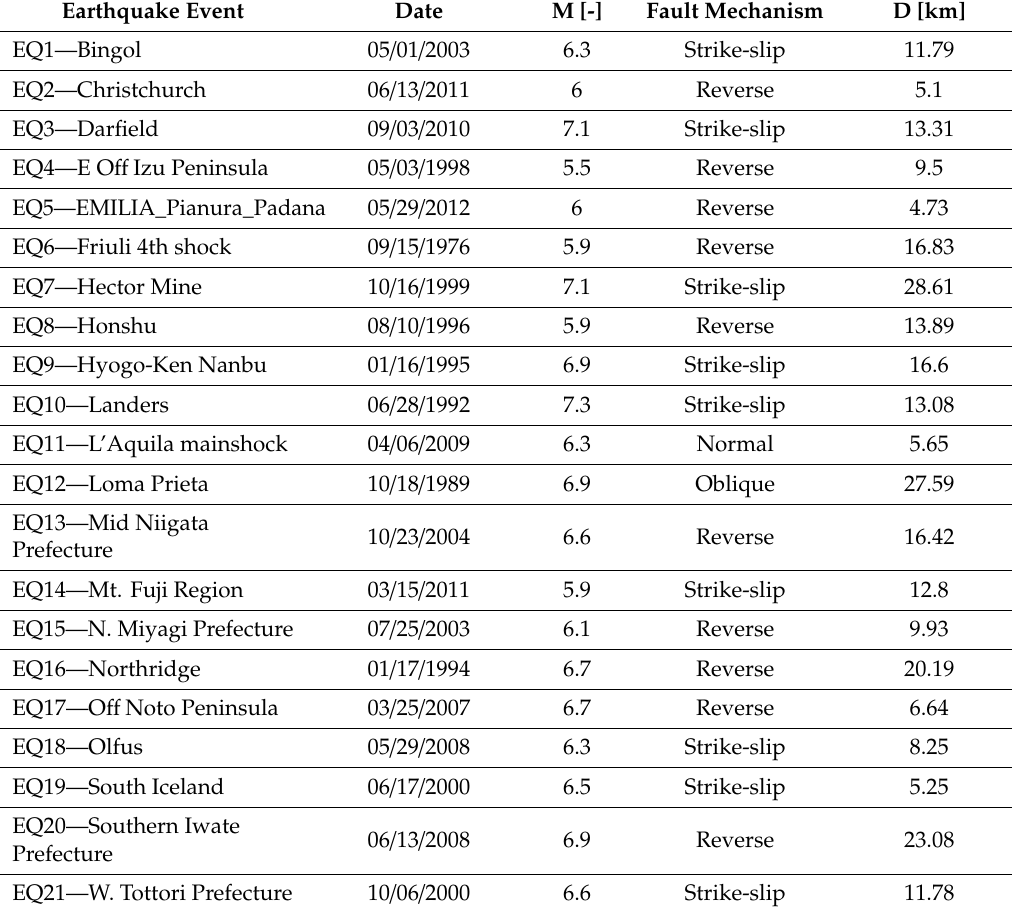
Table 3. Selected ground motion records from European Strong Motion Database [37]: D denotes the epicentral distance of the event in and M the related